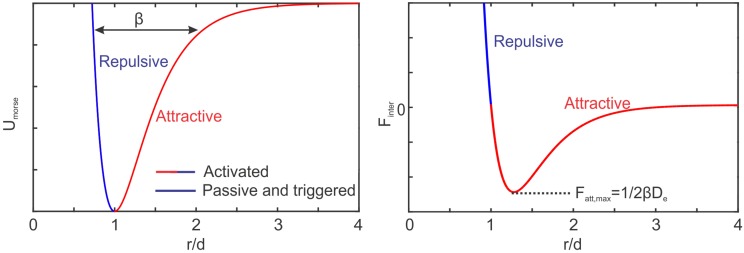
Schematic of Morse potential and the resulting adhesive force.Morse potential is used in this study to mimic inter-platelet attractive/repulsive forces. Passive and triggered platelets only generate repulsive forces to prevent overlap, whereas activated platelets attract each other as well.